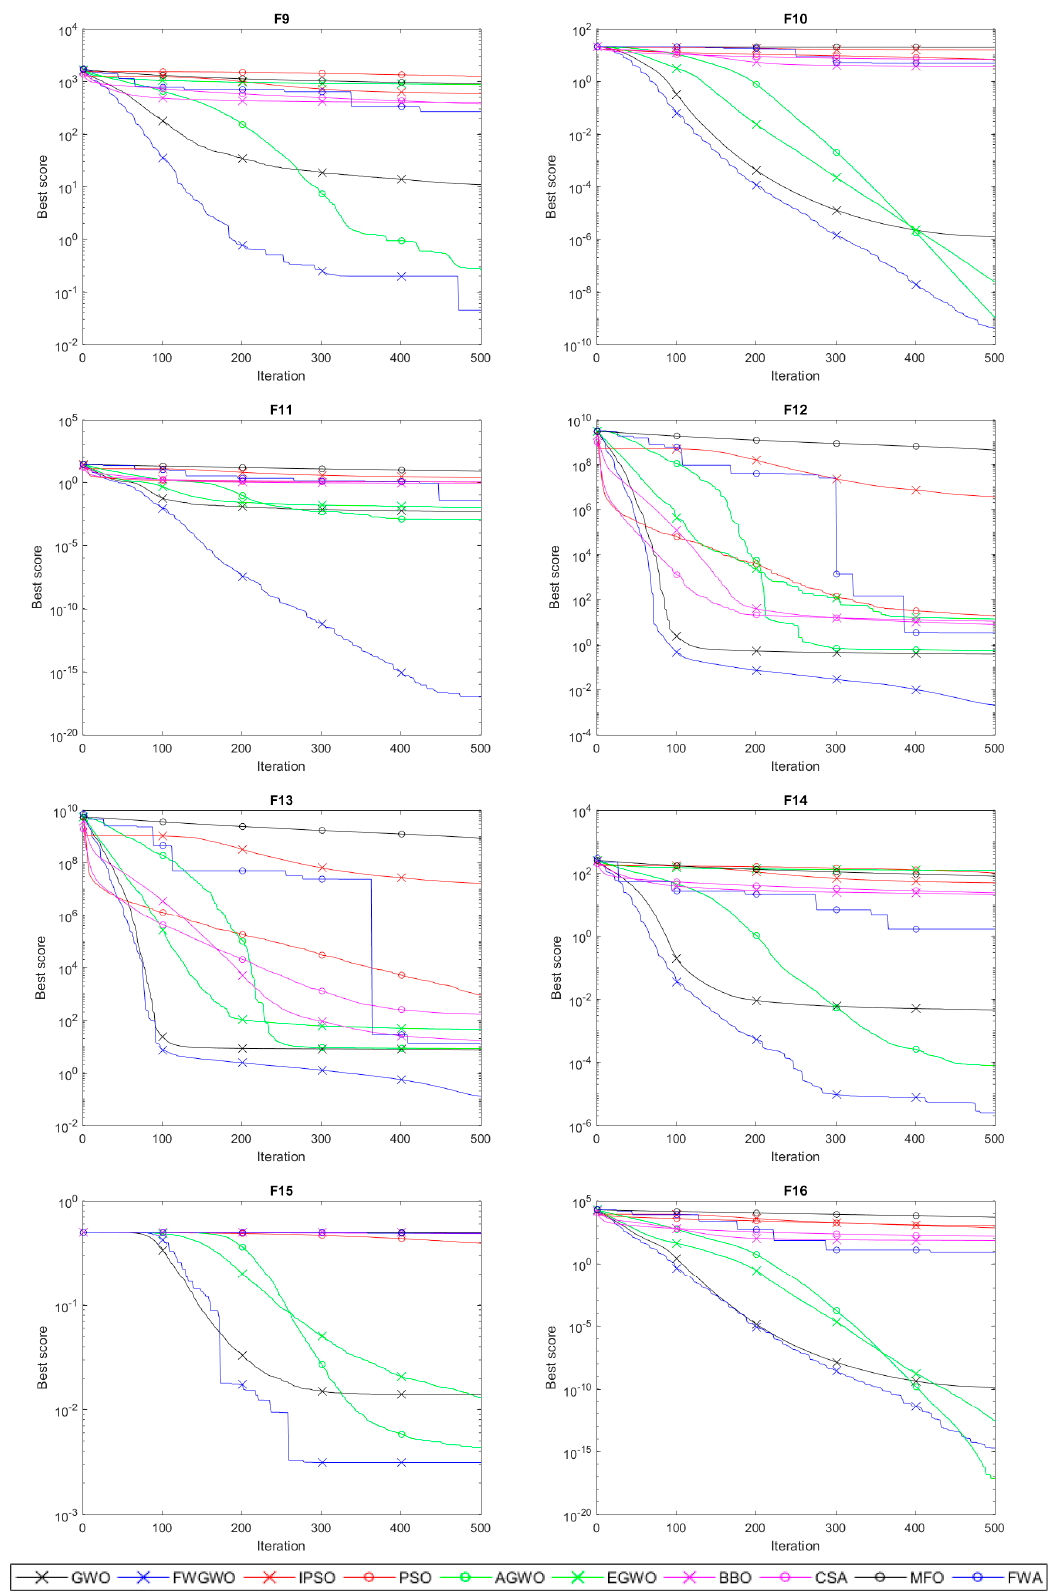
Figure 3. Convergence curves of the unimodal functions.